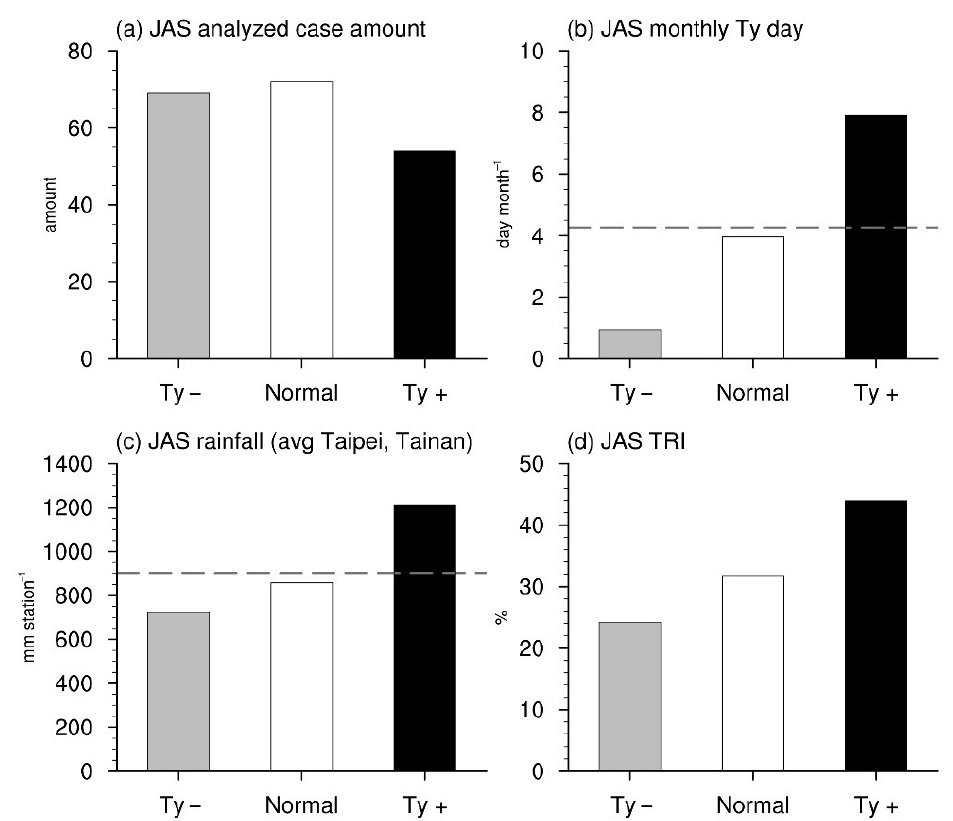
Figure 2. ( a ) The total amount of the analyzed cases from 1950 to 2014 for the Ty − category (gray bar), the Ty + category (black bar), and the normal cases (white bar). ( b ) Same as ( a ) but for monthly typhoon invasion days (unit: day month − 1 ). ( c ) Same as ( a ) but for total rainfall averaged from the Taipei and Tainan observation stations (unit: mm station − 1 ). ( d ) Same as ( a ) but for the proportion of the Taiwan Rainfall Index (TRI) (each category to all; unit: %). The gray dashed lines in ( b ) and ( c ) indicate the climatology calculated over the analyzed period.